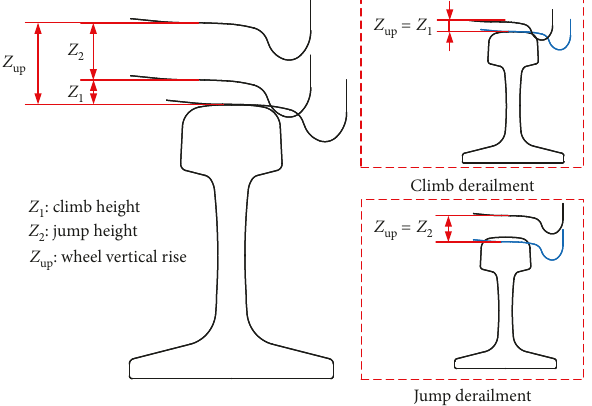
Figure 14: The definition of wheel vertical